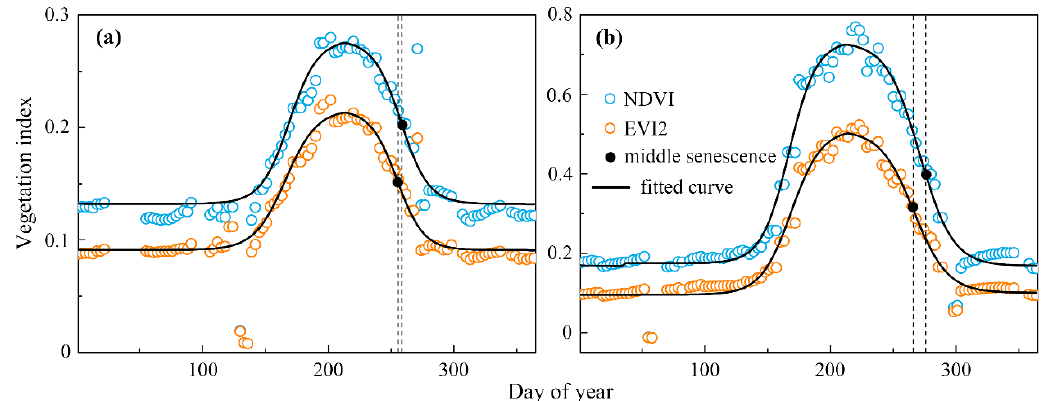
Figure 3. Moderate Resolution Imaging Spectroradiometer (MODIS) normalized difference vegetation index (NDVI) and 2-band enhanced vegetation index (EVI2) curve fitting and middle senescence date extraction. ( a ) A sample pixel in the steppe area and ( b ) a sample pixel in the meadow area. The black dot denotes the calculated middle senescence point of alpine grassland on the fitting curves and the corresponding horizontal axis coordinate is the middle senescence date (MSD).